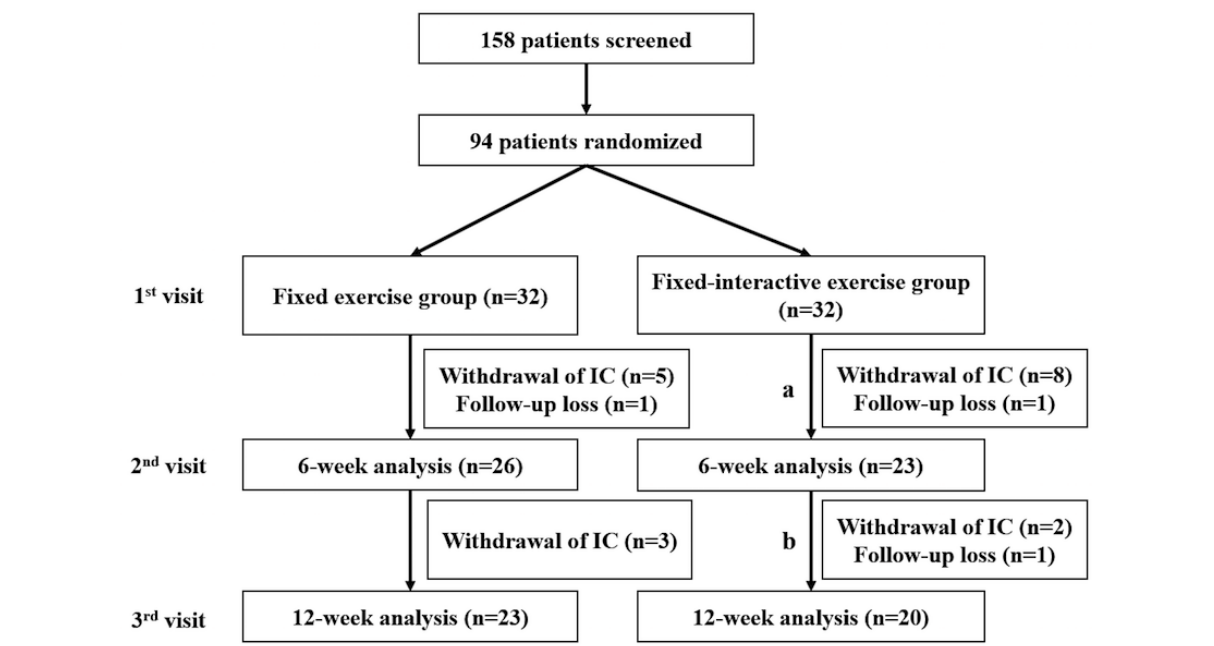
Figure 5. Flow of the study groups. (a) Participants using the fixed-regimen app; (b) participants using the interactive-regimen app. IC: informed